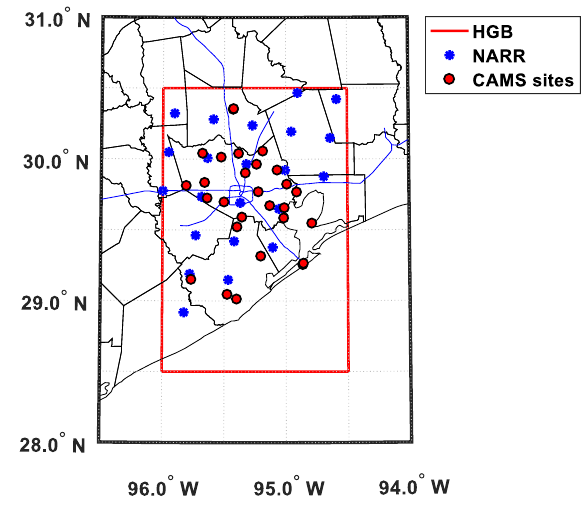
Figure 1. Research area: the HGB region (red box), NARR reanalysis data points (blue “*”), CAMS sites (red